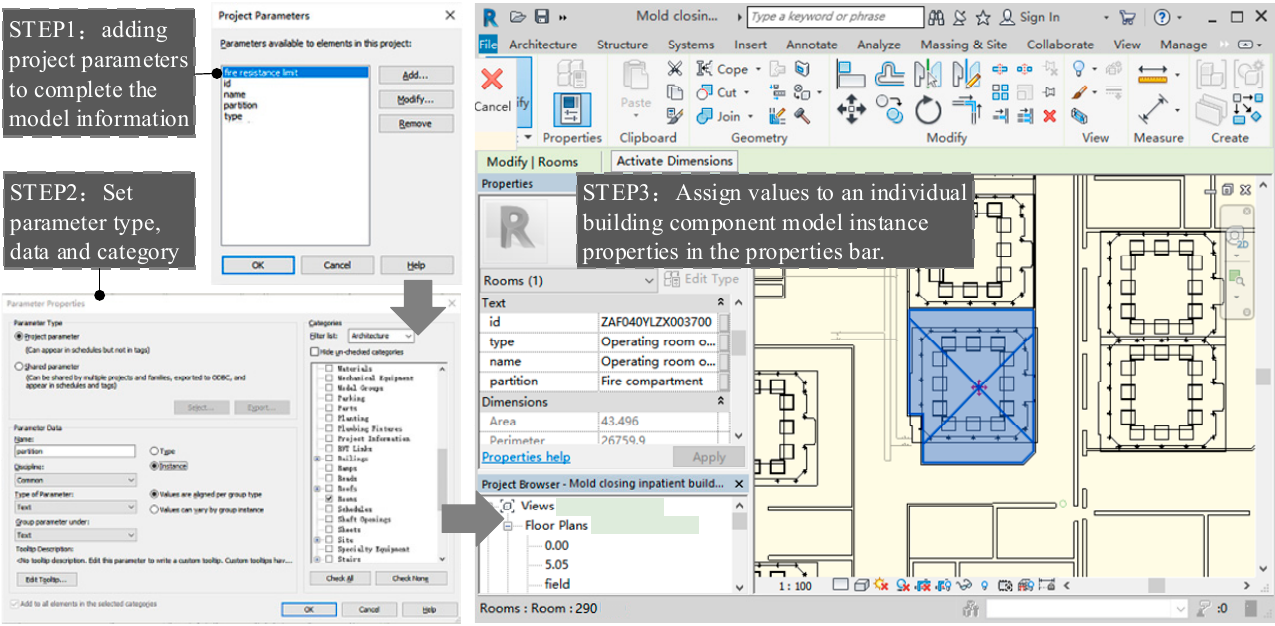
Figure 10. Process of BIM preprocessing in